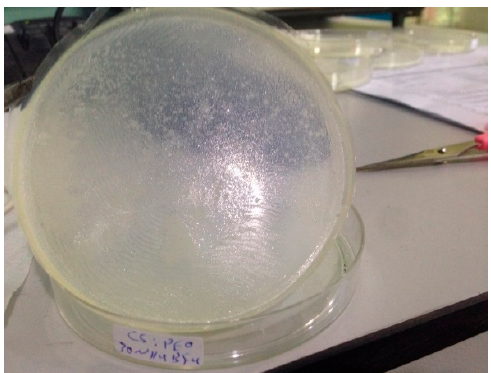
Figure 3. Realistic image of the prepared solid polymer electrolyte of CSPEH3 sample.